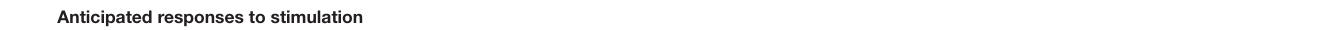
TABLE 3a | Anticipated vs. actual outcomes—pre-DBS.